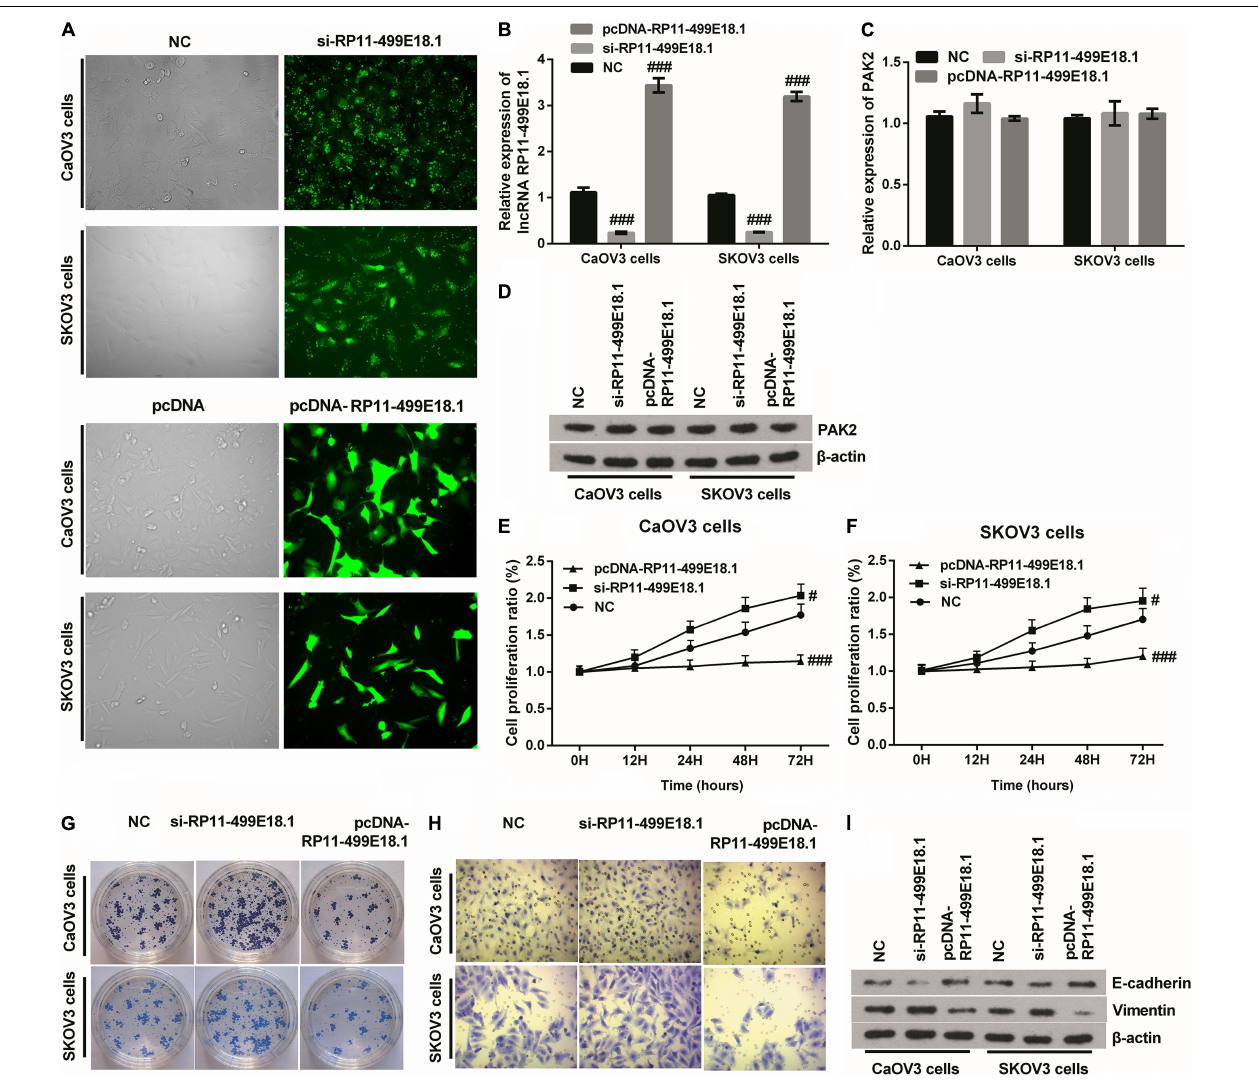
FIGURE 4 | RP11-499E18.1 overexpression obviously suppressed cell proliferation, migration, colony formation, and EMT transformation. The sequences of NC and si-RP11-499E18.1 were respectively transfected into CaOV3 and SKOV3 cells to silence RP11-499E18.1 expression. The plasmids pcDNA 3.1 and pcDNA-RP11-499E18.1 were respectively transfected into CaOV3 and SKOV3 cells to overexpress RP11-499E18.1. (A,B) The transfection efficiency was high, and RP11-499E18.1 was successfully silenced and overexpressed in CaOV3 and SKOV3 cells. (C,D) There was no obvious influence of RP11-499E18.1 knockdown or overexpression on the expression of PAK2. (E–H) The proliferation, colony formation, and migration of CaOV3 and SKOV3 cells were distinctly repressed by RP11-499E18.1 overexpression, while notably promoted by RP11-499E18.1 knockdown. (I) The expression of EMT-related E-cadherin was distinctly increased, while Vimentin was notably decreased by RP11-499E18.1 overexpression. RP11-499E18.1 knockdown performed the opposite effects. NC, negative control; si, small interfering; PAK2, P21 (RAC1) activated kinase 2; EMT, epithelial–mesenchymal transition. # p < 0.05, ### p < 0.001.